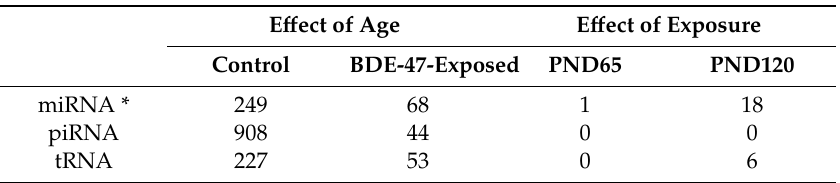
Table 1. Number of individual miRNA, piRNA and tRNA significantly (false discovery rate (FDR) adjusted p ≤ 0.05) di ff erentially expressed (twofold) in rat sperm in relation to age and exposure to BDE-47. E ff ect of Age E ff ect of